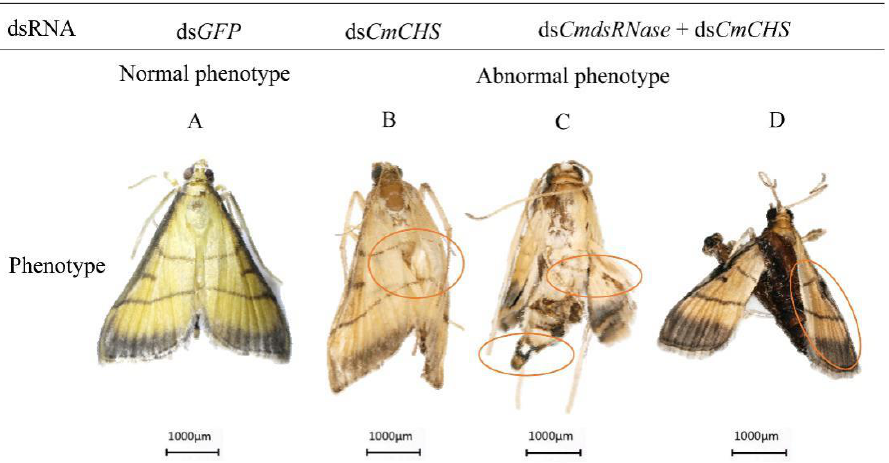
Figure 12. Abnormal morphology of C. medinalis pupae after dsRNA injection. ( A ) ds GFP -injected pupa. ( B ) Darkened pupa. ( C ) Malformed pupa. Red circles indicate deformed changes in the pupa. Each scale bar represents 1000 μ m.